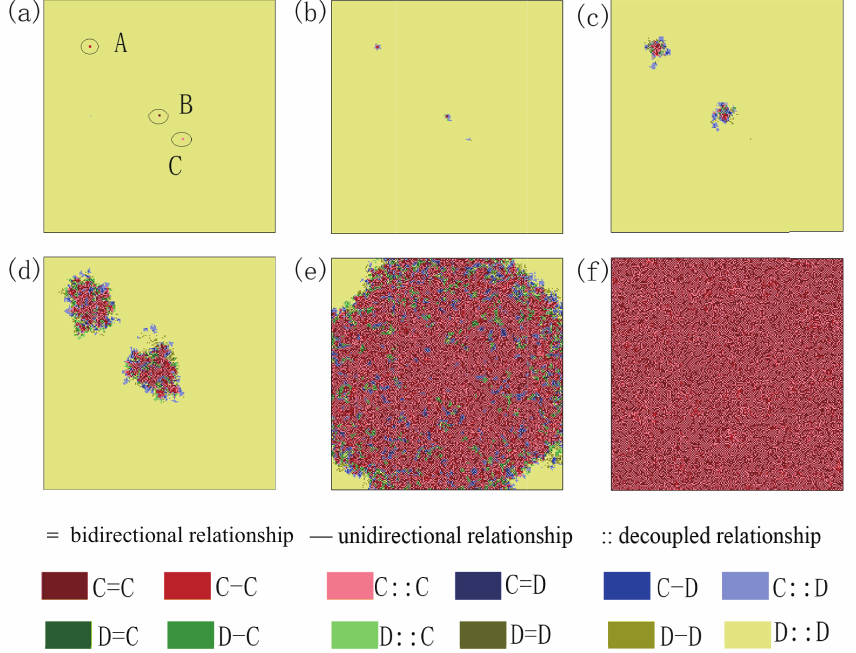
Figure 6. Characteristic snapshots of time evolution at β = 0.5 and τ = 8. The snapshots start from the special prepared distribution of strategies, where the positions of A, B, and C are 2 × 2 cooperative clusters with unidirectional (—), bidirectional (=), and decoupled (::) relationships, respectively. Red (yellow) points indicate that players in both networks are cooperators (defectors) and blue (cyan) dots denote that players in network A (bottom) are cooperators (defectors), while players in network B (top) are defectors (cooperators). Moreover, the depth of color indicates the different strength of the coupled relationship. For instance, dark red signifies that cooperators located at the corresponding position are a bidirectional coupled relationship, medium red means that cooperators in both networks have a unidirectional coupled relationship (i.e., only one layer of network cooperators can build coupled connection), and light red characterizes that there is a decoupled relationship between cooperators. It should be noted that, due to the fact that the results obtained on both networks are qualitatively consistent, only the results obtained on the bottom network are shown here. In addition, the generations of MC from subgraphs ( a – f ) are 0, 20, 300, 1000, 5000, and 50,000, respectively. Other parameters are exactly the same as those in Figure